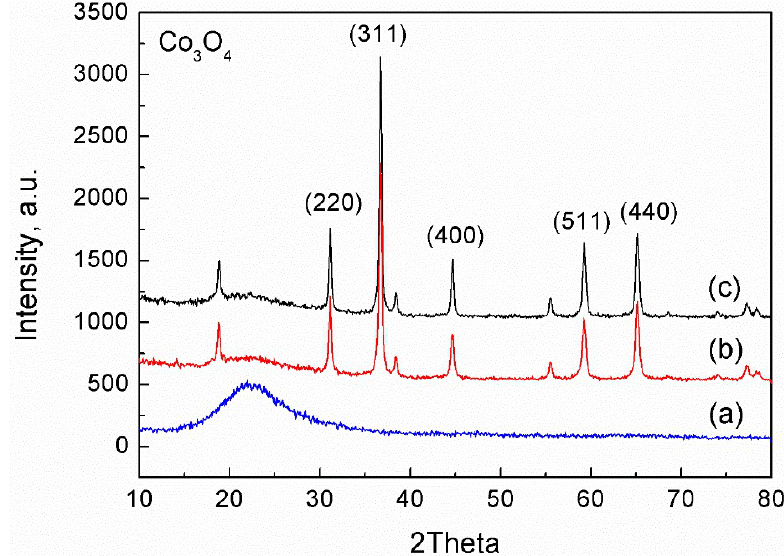
Figure 1. XRD patterns of as-prepared Co/fumed SiO 2 catalysts using different approaches (Co 3 O 4 , JCPDS file No: 43-1003): ( a ) pure fumed SiO 2 , ( b ) improved preparation method, and ( c ) conventional preparation method.